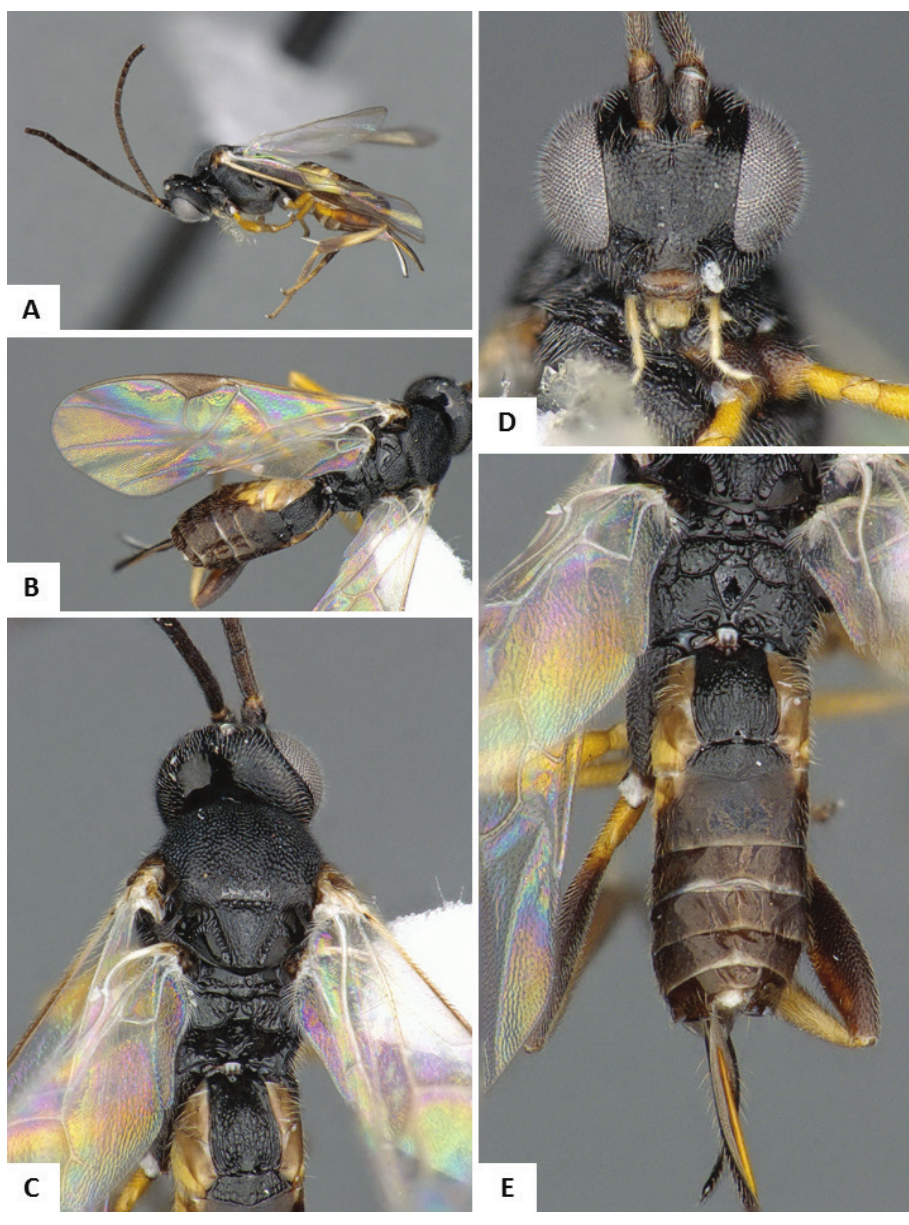
Figure 5. Apanteles hemara female specimen from Kenya (Voucher code: